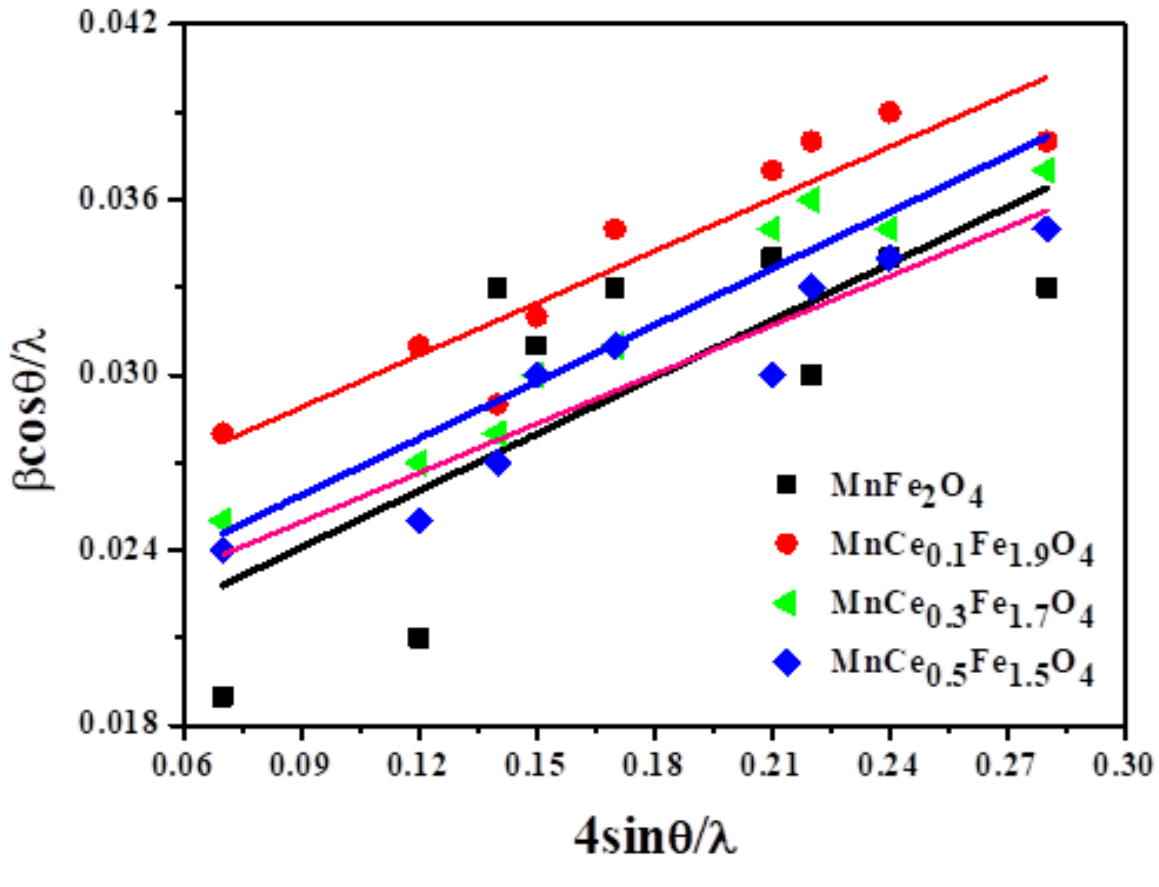
Figure 3. W–H plots of spinel MnCe x Fe 2 − x O 4 (x = 0.0, 0.1, 0.3 and 0.5) NCs.